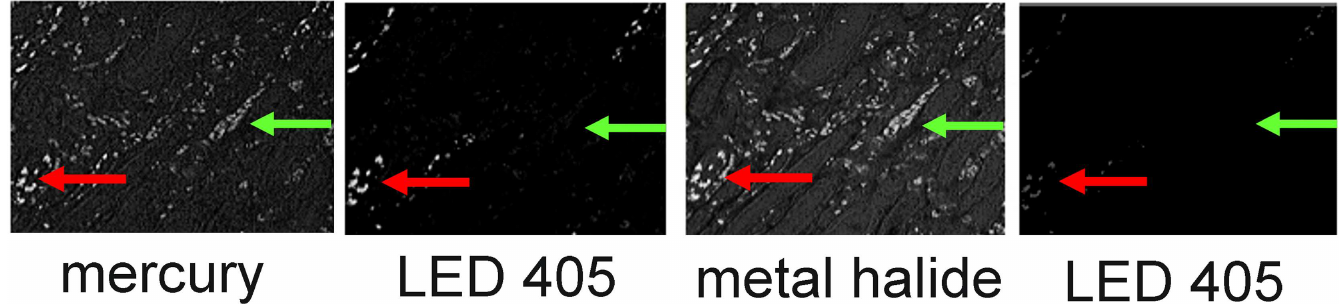
Fig 2. Highlevels of autofluorescence and fastphotobleachingof specificfluorescence whenilluminatingQdotswithmetalhalide. FFPE section stainedwith Qdot 655 was imagedsuccessively using mercurybulb, LED405 & MetalHalidesource. The imagesare intensityimagesat 655nm.Red arrows: specific 655 fluorescence; green arrows: autofluorescence. The imagetaken with the first exposure to LED405nm illumination. (LED405 (1) ) shows the specific stainingwith littleautofluorescence when the sectionis illuminatedwith LED 405nm.Metalhalide exposure led to high level autofluorescence and fast photobleaching of the specific fluorescence, confirmedwith a second set of imageswith LED 405nm (LED405 (2) ). Similarresultswere obtained with all otherQdots.